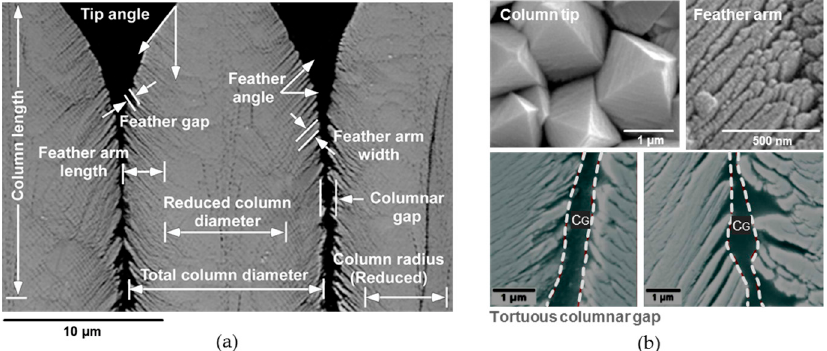
Figure 3. SEM image of a cross-sectional view of an EB-PVD 7YSZ column. The microstructures are shown for: ( a ) columnar geometry of the top coat (TC) with microstructural parameters identified for modeling purposes; and ( b ) closer look of the top view of pyramidal column tip, side view of feathers with irregular feather arrangements (top), and tortuous columnar gaps due to irregular feather arms (bottom). Reprinted with permission from [25]; Copyright 2006 Elsevier.